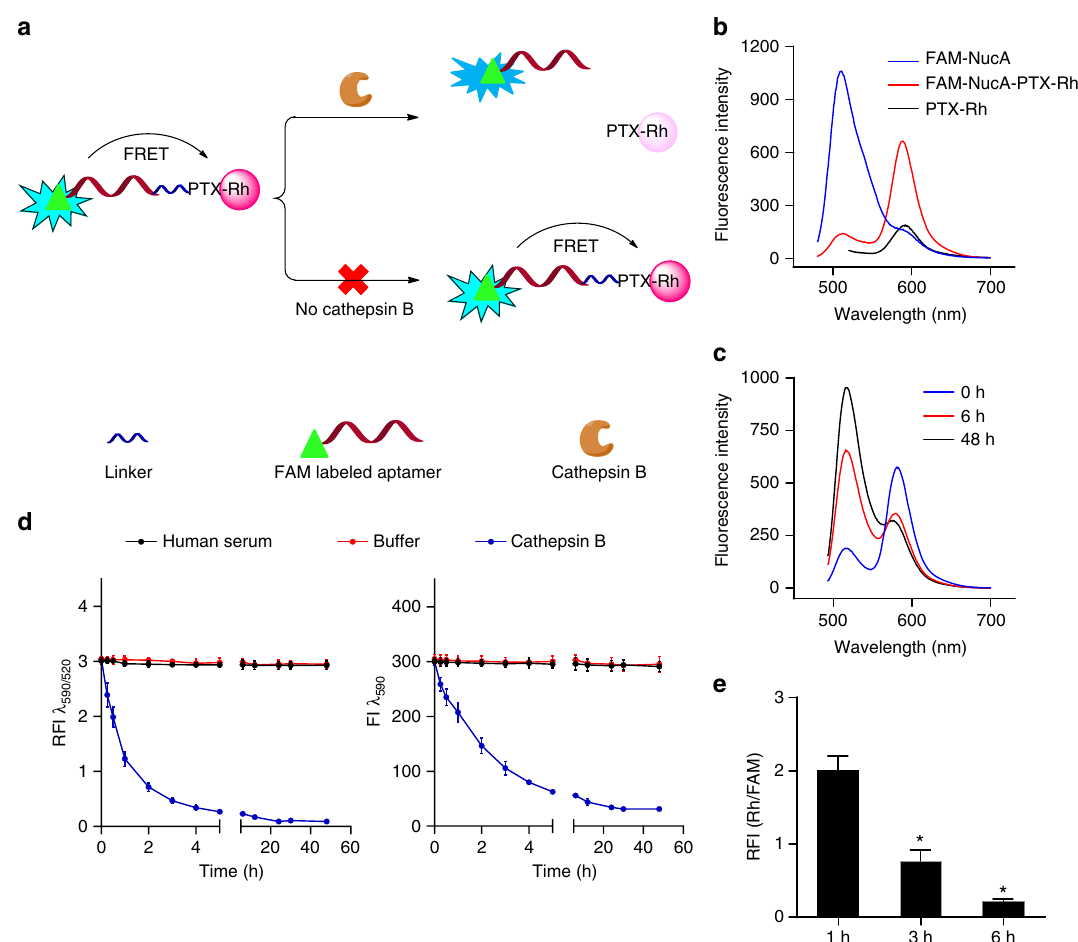
Fig. 2 The cathepsin B-dependent release of PTX in FAM-NucA-PTX-Rh. a Schematic diagram of the utilization of FRET in FAM-NucA-PTX-Rh for tracking the rupture of the cathepsin B-labile linker. b Fluorescence emission spectra of FAM-NucA-PTX-Rh, FAM-NucA and PTX-Rh ( λ ex = 470 nm). All compounds were at a concentration of 2 μ M. c Fluorescence emission spectra of FAM-NucA-PTX-Rh ( λ ex = 470 nm) in the presence of cathepsin B upon time. FAM-NucA-PTX-Rh and cathepsin B were at a concentration of 2 μ M and 0.5 unit mL − 1 , respectively. d The fl uorescence analysis of FAM-NucA-PTX- Rh in human serum and buffer (pH 5.0, containing DTT) without or with cathepsin B upon time. The relative fl uorescence intensity of rhodamine to FAM (RFI λ 590 / λ 520 ) indicates the concentration of FAM-NucA-PTX-Rh, and the fl uorescence intensity of rhodamine (FI λ 590 ) indicates the concentration of the conjugated PTX-Rh. FAM-NucA-PTX-Rh and cathepsin B were at a concentration of 2 μ M and 0.5 unit mL − 1 , respectively. Error bars indicate mean ± standard deviation. n = 3. e The intracellular release of PTX-Rh from FAM-NucA-PTX-Rh in SKOV3 cells monitored by fl ow cytometry. The relative median fl uorescence intensity of rhodamine to FAM (RFI Rh/FAM) in SKOV3 cells was examined 1, 3, and 6 h after incubation with 200 nM FAM-NucA-PTX-Rh. Error bars indicate mean ± standard deviation. n = 3, * P <